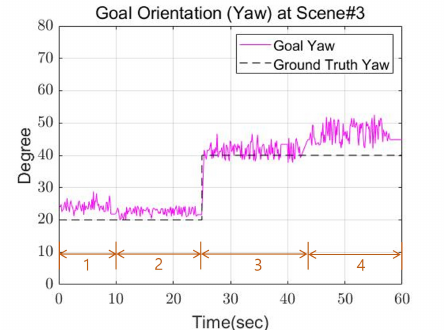
Figure 23. The goal orientation of Scene